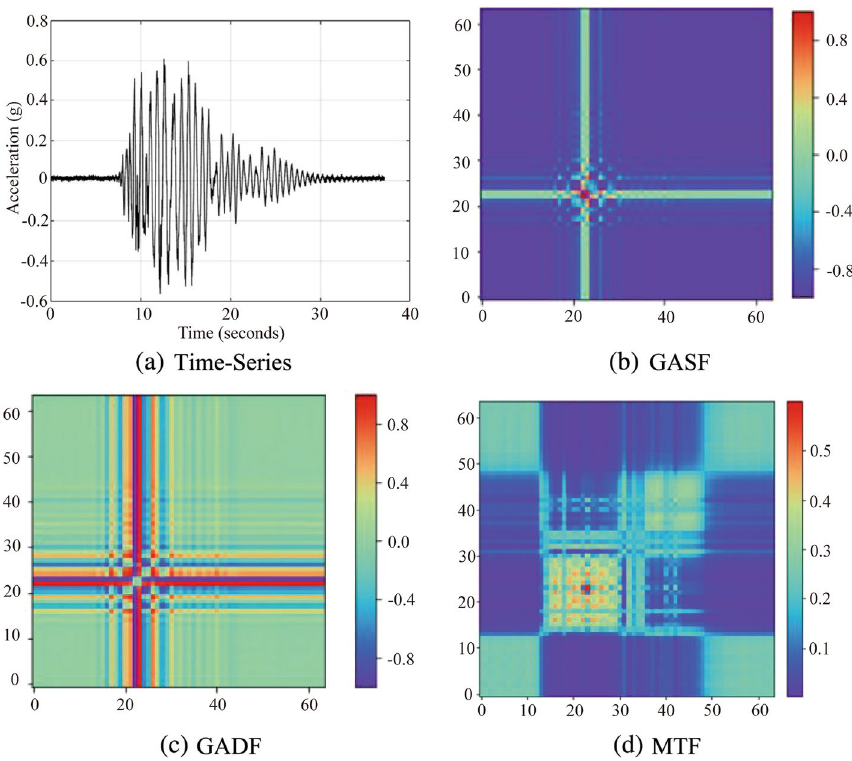
Fig. 3 Time series encoding scheme adopted by Mantawy and Mantawy